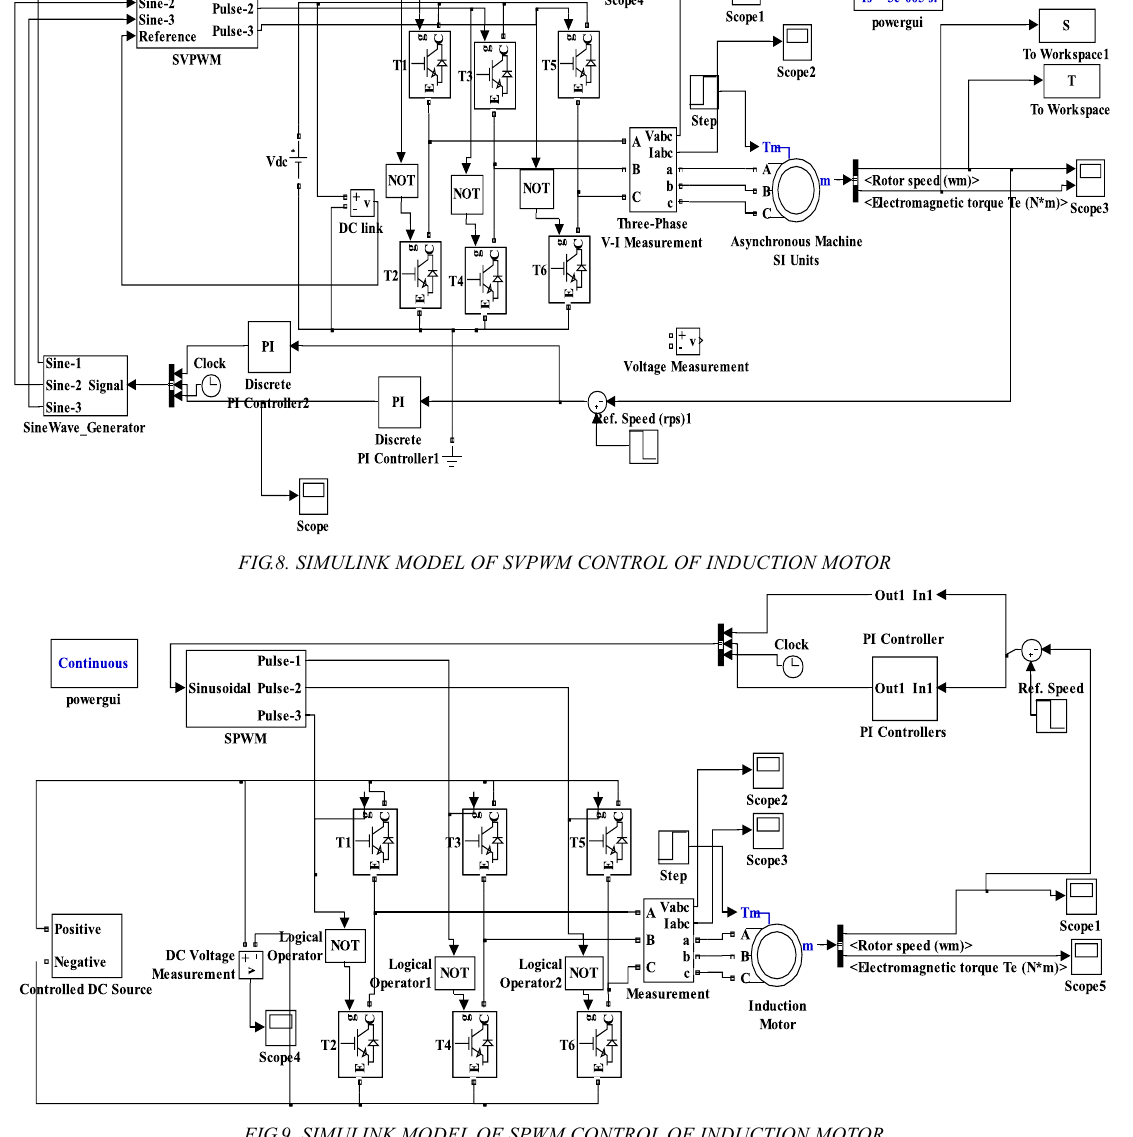
FIG.9. SIMULINK MODEL OF SPWM CONTROL OF INDUCTION